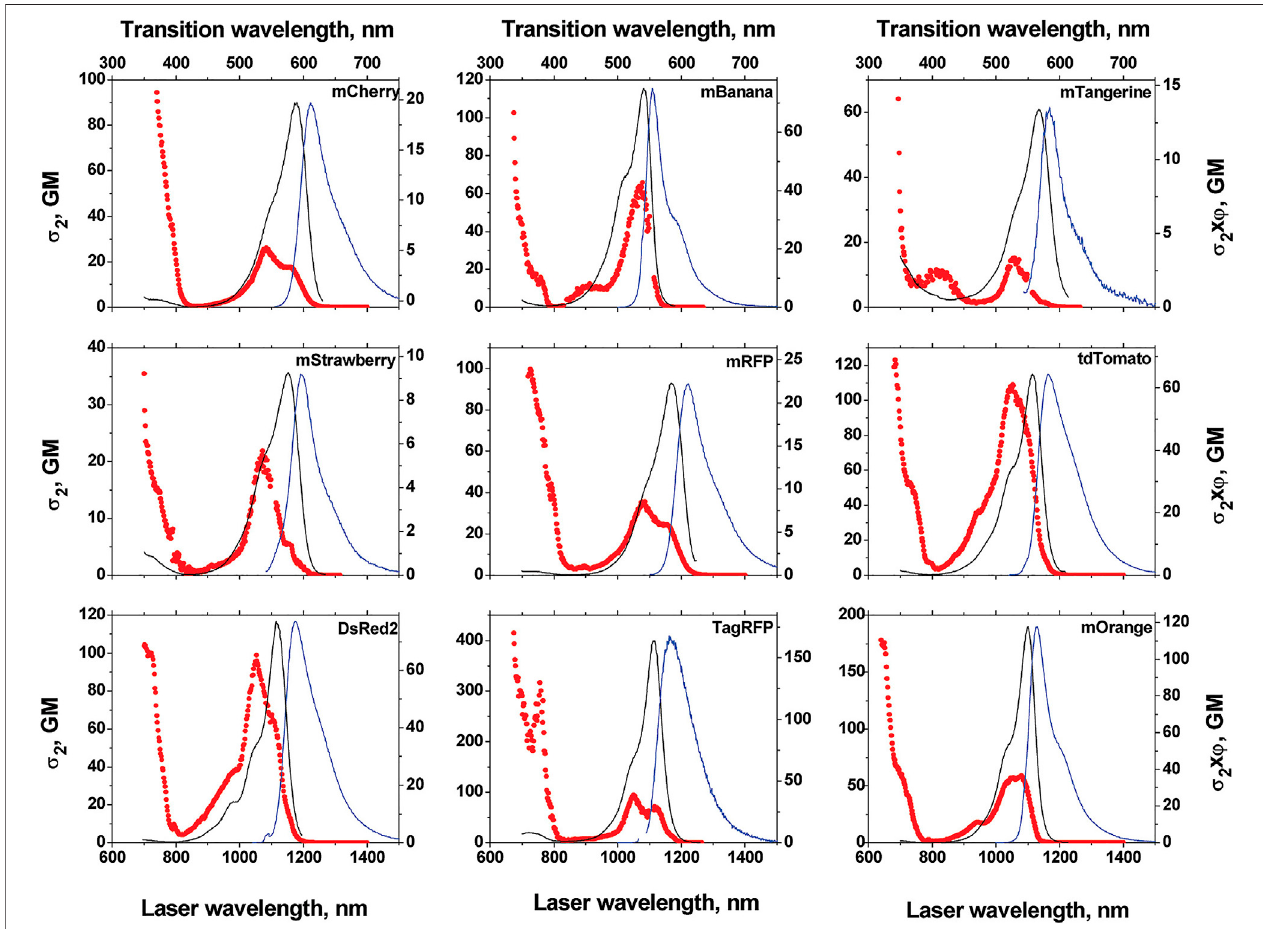
FIGURE6| 1PAand2PAspectraof fl uorescentproteinsofthe “ fruitseries ” .Leftaxisshowsthe2PAcross-section σ 2( λ ) permaturechromophore,rightaxisshows corresponding σ 2( λ ) Φ f values. Adapted with permission from ref. (Drobizhev et al., 2009). Copyright 2009 American Chemical Society.